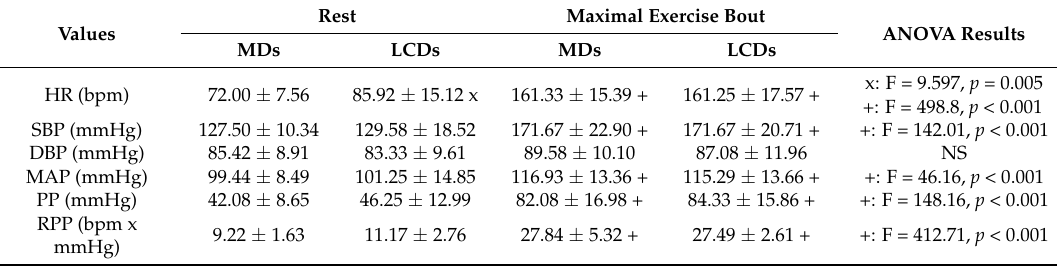
Table 5. Circulatory variables of participants in the low carbohydrate diets (LCDs) and mixed diets (MDs) groups.